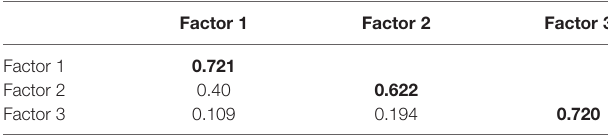
TABLE 5 | Square root of AVE and correlations between factors.